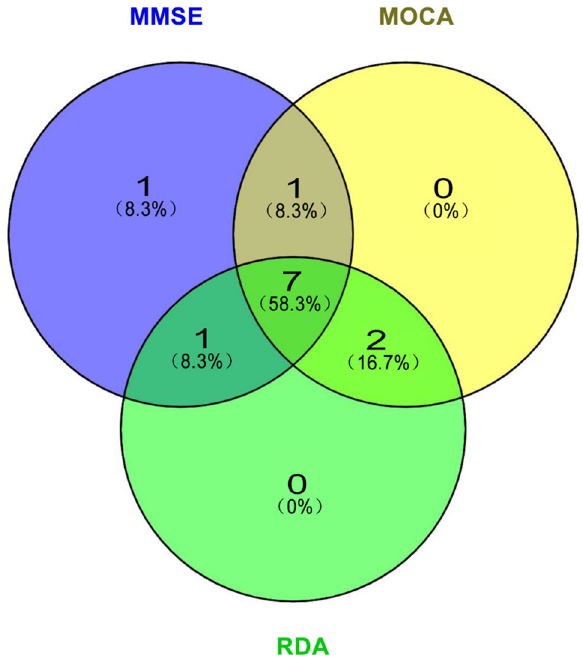
Figure 3. In the Venn diagram, each circle represents the difference variable in a model, the number of overlaps in the circle represents the number of common variables in the two models, and the overlap area represents the number of unique variables in each model (purple: MMSE; Yellow: MOCA; Green: